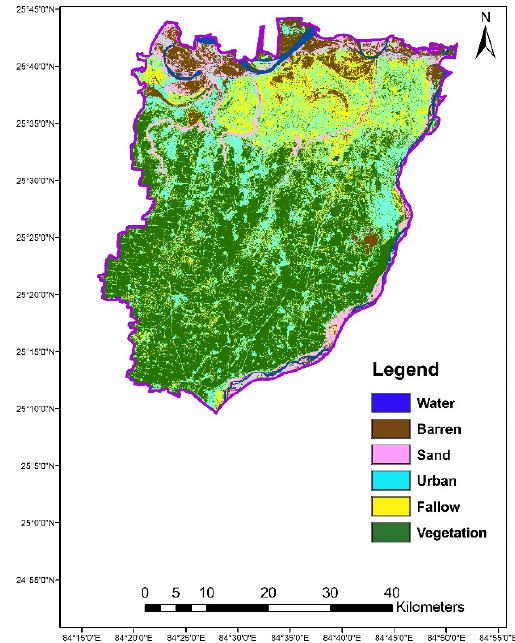
Figure 5. The Land use and Land cover (LULC) classification in the study area.